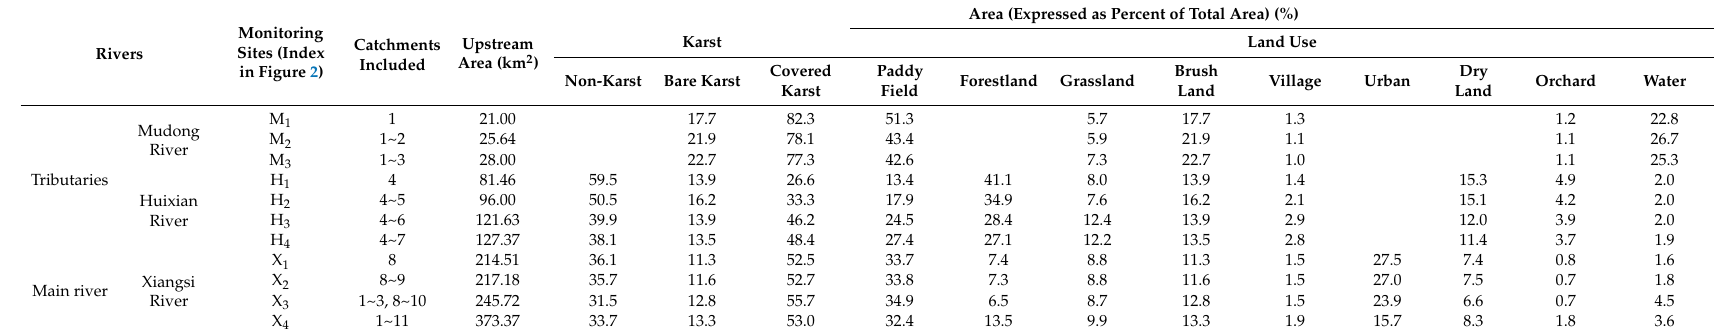
Table 1. Distribution of the eleven monitoring sites (M 1 –M 3 , H 1 –H 4 and X 1 –X 4 ), catchments (1–11), and the share of karst and land use area in Huixian karst wetland